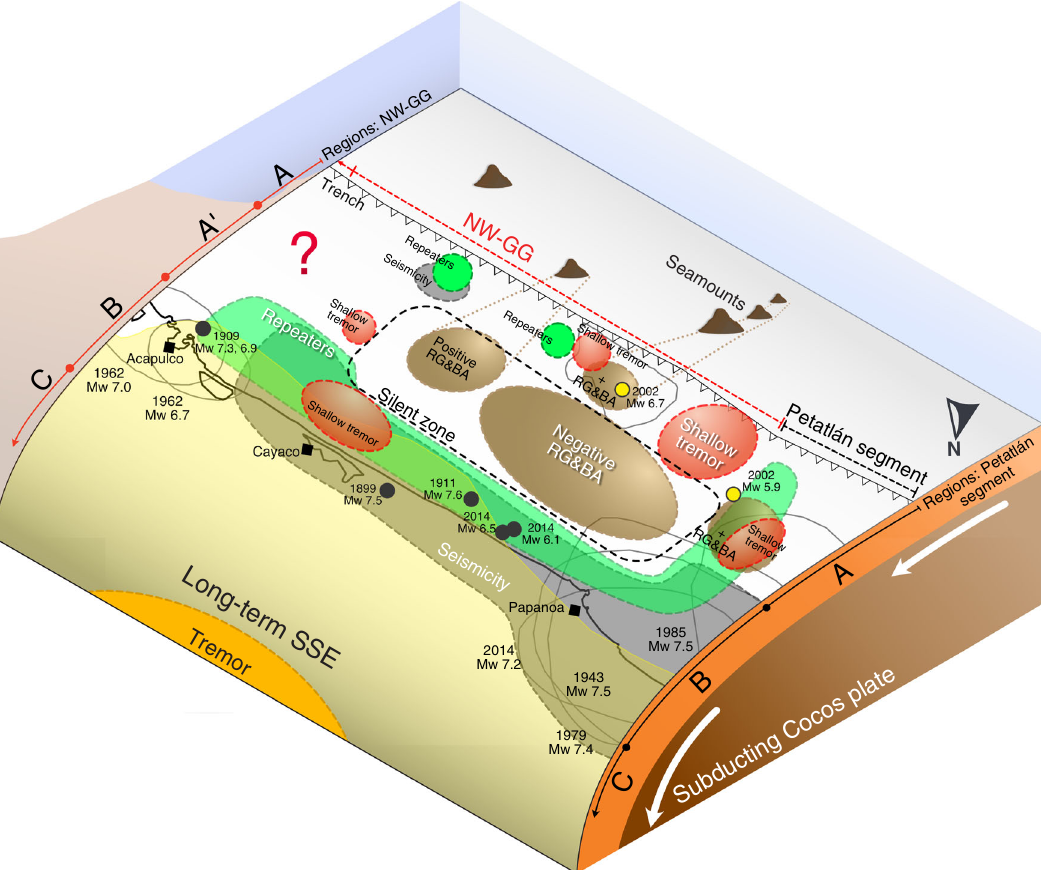
Fig. 4 Plate interface conceptual model. Trench is shown with white triangles and the silent zone is shown inside a black dashed line. Red, green, brown, yellow, orange and grey areas are locations of STs, repeaters, RG&BAs, long-term SSE, tremor and seismicity, respectively. Black and yellow circles indicate the epicentres of large earthquakes and tsunami earthquakes, respectively. Estimated rupture areas of previous M > 7 earthquakes are outlined in grey lines. Regions described in the main text for the NW-GG and Petatlán segment are included along arrows divided in